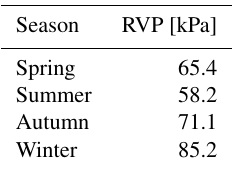
Table 6. Comparison of Yeti annual daily aggregate emissions [td − 1 ] with reported values.